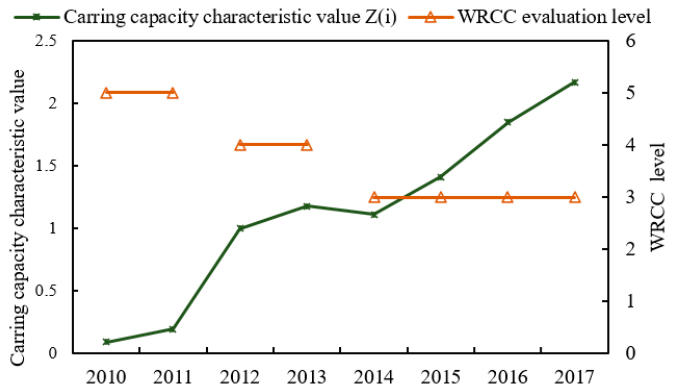
Figure 4. WRCC development trend in Baoding from 2010 to 2017.